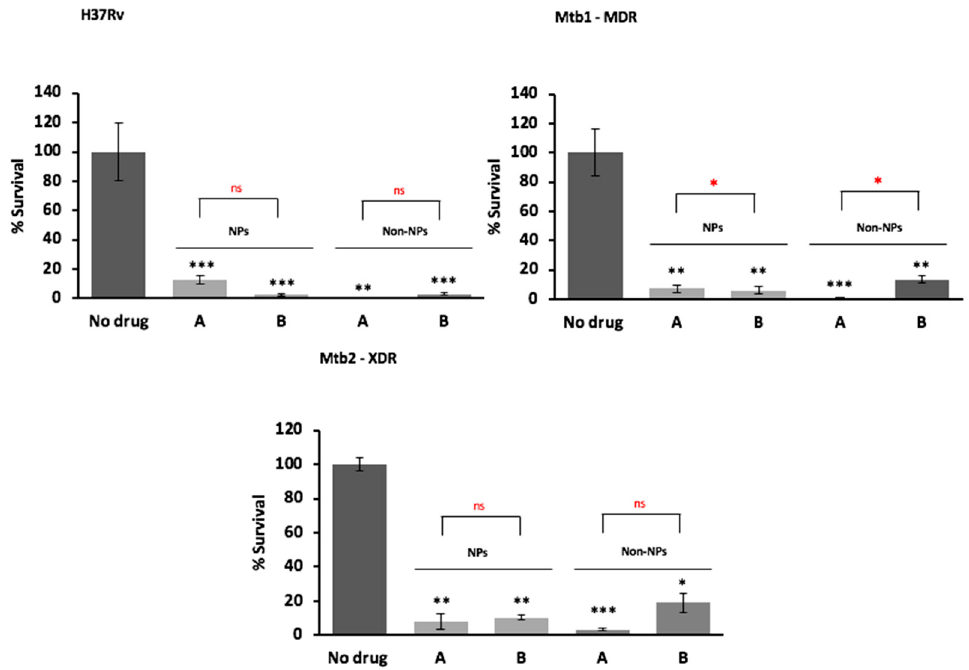
Figure 9. In vitro antimicrobial activity of solutions obtained from dried powder (A) and an analogous dried powder without verapamil (B) against drug susceptible (H37Rv) and drug resistant Mtb strains (M / XDR), as nanoparticles formulation (NPs) or as free solution of the drugs without HA (Non-NPs) at day 3 post-infection. Values are expressed as mean of triplicate and bars represent standard deviation (ns = not statistically significant; * significant p < 0.05; ** highly significant p < 0.01). Powder A (NPs)—rifampicin 31.3 µ g / mL; isoniazid 16.1 µ g / mL; verapamil 10.7 µ g / mL (as baseline); low molecular weight HA 31.4 µ g / mL; powder B (NPs)—rifampicin 31.4 µ g / mL (as baseline); isoniazid 19.8 µ g / mL; low molecular weight HA 31.4 µ g / mL. Solution A (Non-NPs)—rifampicin, 30 µ g / mL; isoniazid, 15 µ g / mL; verapamil, 10 µ g / mL (as baseline); solution B (Non-NPs)—rifampicin, 30 µ g / mL (as baseline); isoniazid 17.6 µ g / mL. The levels of significance were calculated comparing each of the mixtures with the control with no drug denoted in the graph by black * and by comparing each mixture encapsulated with the non-encapsulated formulation symbolized in the graph by the red *.